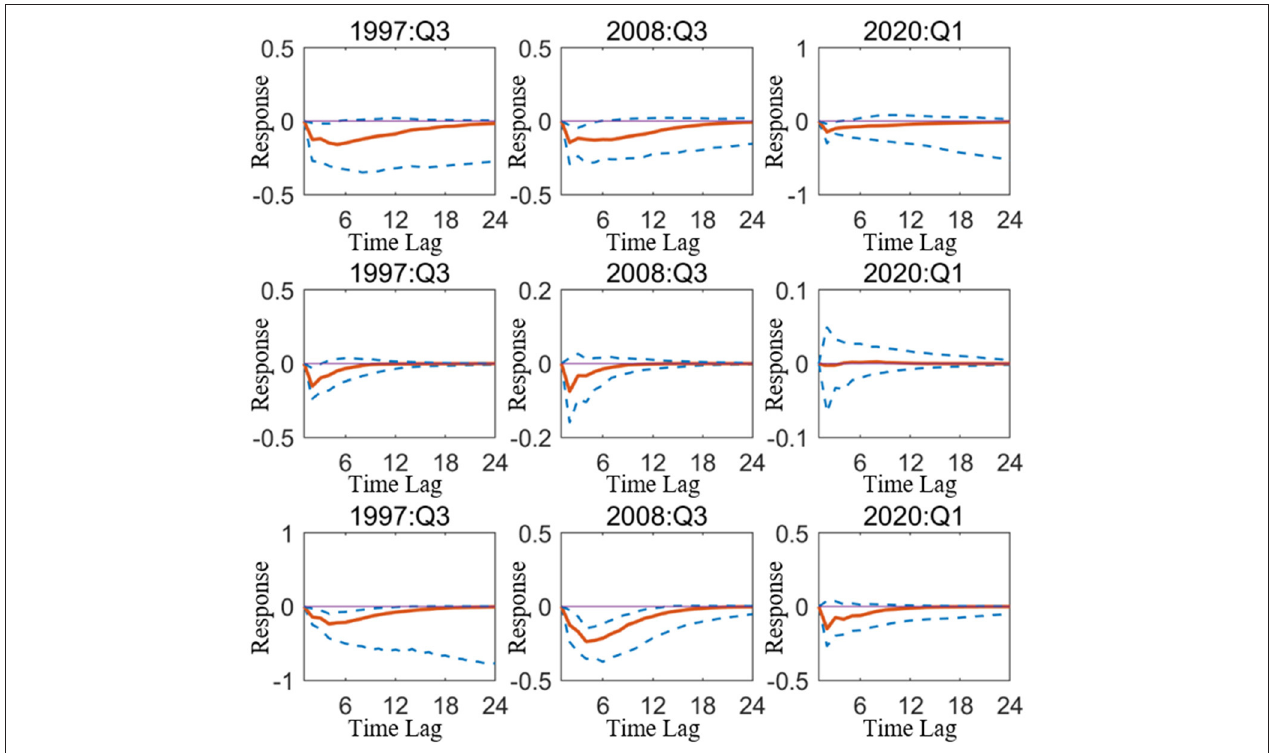
FIGURE 5 | Impulse response of price-based monetary policy acting on mainland China in particular period. The three sub graphs represent the impulse responses of the primary, secondary, and tertiary industries from top to bottom, respectively. One period in the figure denotes one